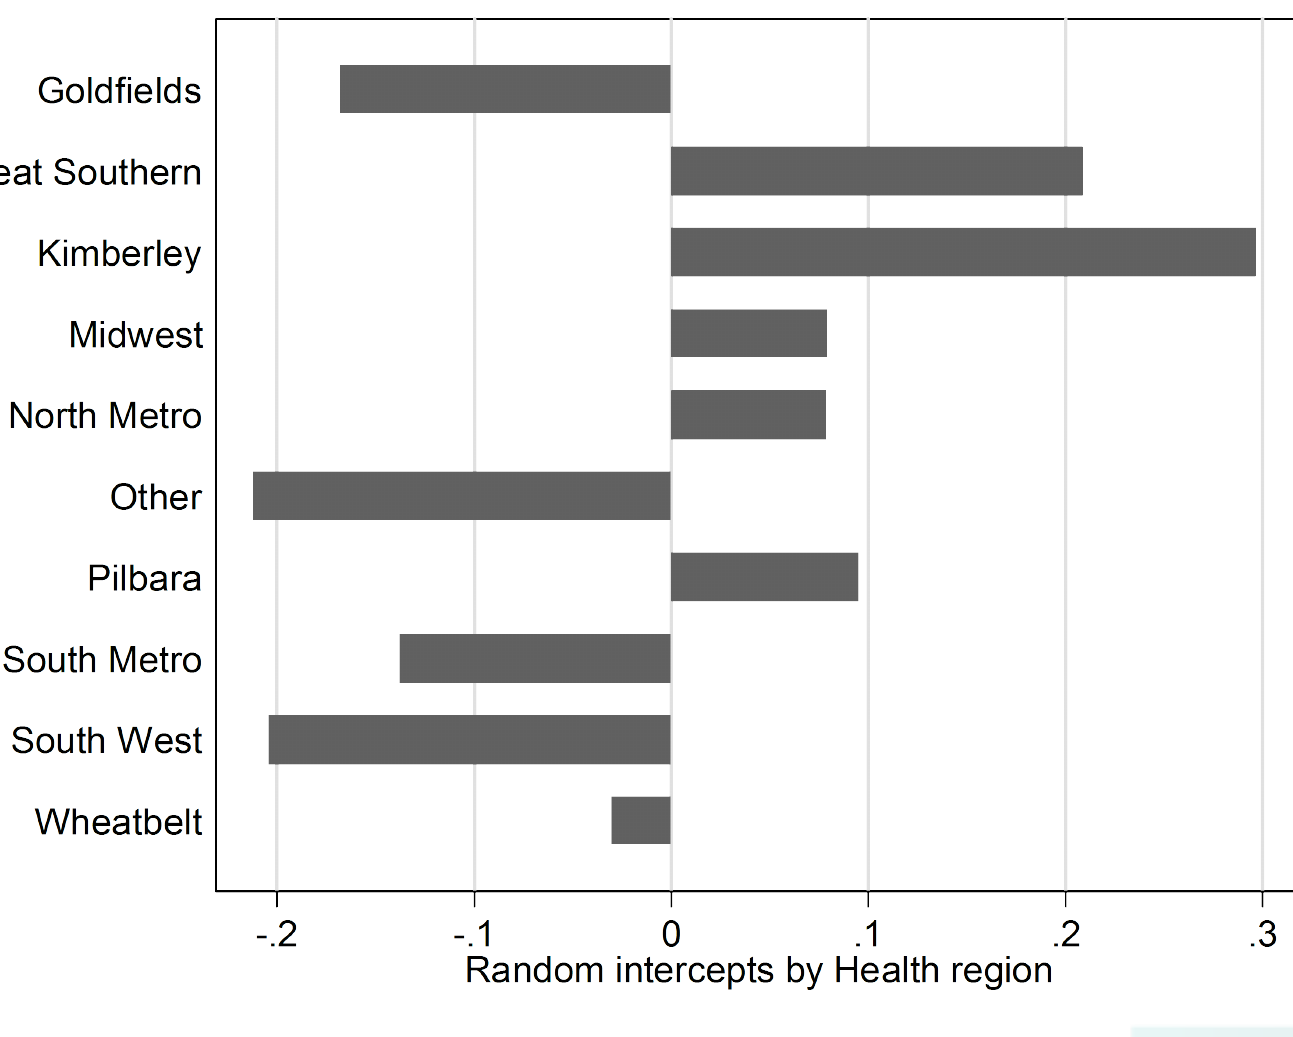
Figure 1: Random intercept estimates for maternal mental health contacts, by health service regions of Western